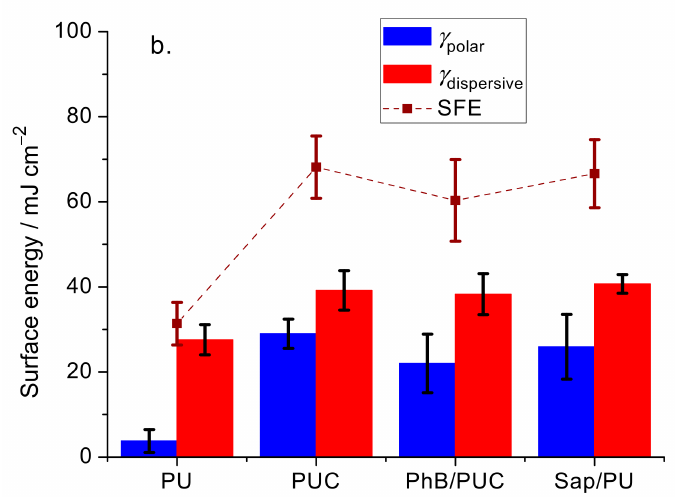
Figure 7. Water contact angles ( a ) and surface energy of PU membranes ( b ). PU—pure polyurethane, PUC—polyurethane composite with ODTMA/Sap particles (without PhB), PhB/PUC—PU compos- ite with